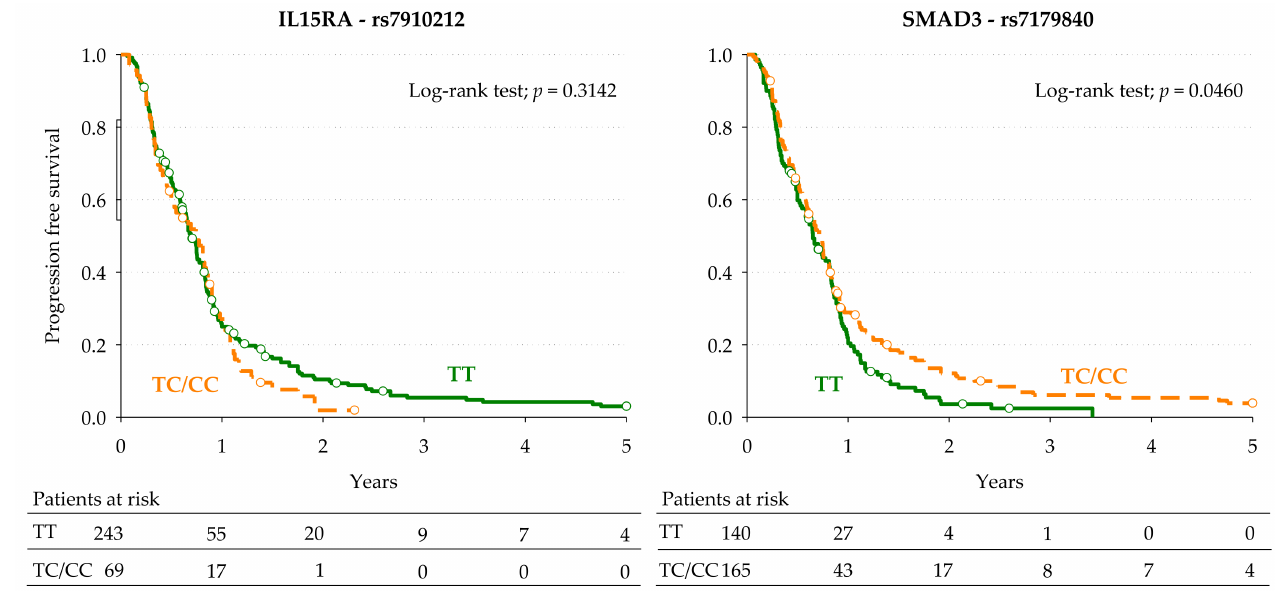
Figure 3. Kaplan-Meier estimates of progression-free survival according to the selected IL15RA -rs7910212 and SMAD3 - rs7179840 polymorphisms in the combined discovery and replication cohorts (pooled population, n = 335).